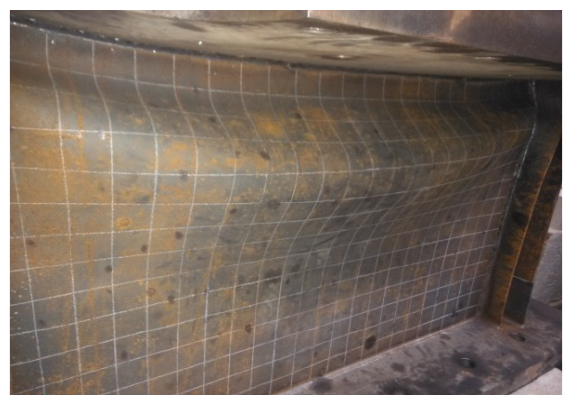
Figure 31. Vertical deformation of infill panel in specimen 2. Under the action of vertical loading, the deformation mode of the column flange is shown in Figure 33 and the out-of-plane displacement distribution of the column flange along the height direction is shown in Figure 34. As indicated by the figure, the large out-of-plane deformation of the column flange was mainly focused on the upper part and torsional deformation occurred in the frame column. The deformation at the bottom of